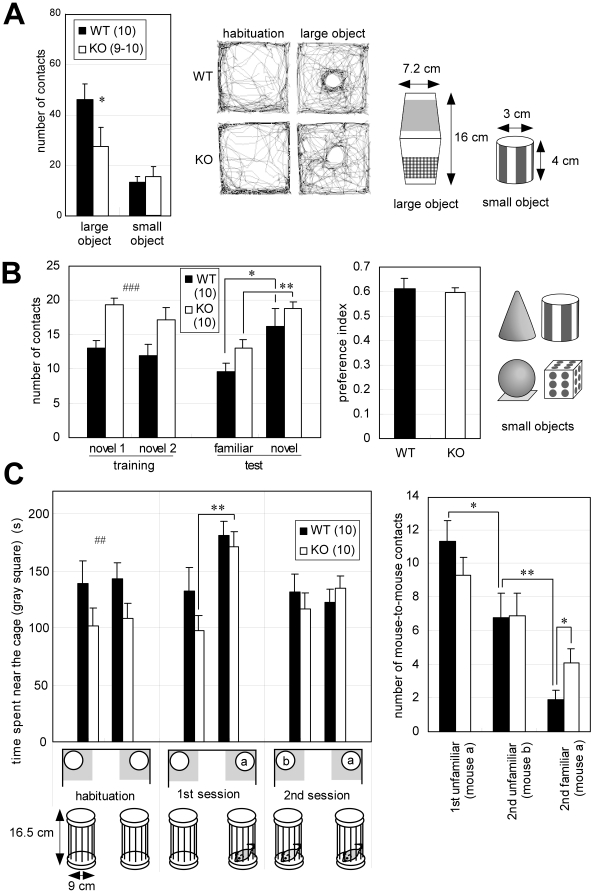
Approach to inanimate and animate objects.(A) Behavioral tests of approach to inanimate objects in the OF. The mice were first placed in the OF box without the object (habituation), then placed again in the OF with the large or small object (right). Approach was measured by the numbers of direct contacts with the large or small object (left). The traces are representative ones of WT and KO mice during the habituation and the test session with the large object (middle; results are given for a pair that showed comparable trace patterns in habituation). Values are presented as means ±SEM. * P<0.05. (B) Novel object recognition test using four kinds of small object (right). novel1 and novel2 indicate that the same kinds of objects were placed in the left and right corners, respectively, of the cages in the training session. familiar and novel indicate respectively that the object was unchanged (novel1) and that a new, differently shaped object was added in place of novel2 in the test session. A novel object preference index was calculated as follows: contacts with novel / total contacts with novel and familiar. Values are presented as means ±SEM. * P<0.05; ** P<0.01. ###
P<0.001 (total contacts, comparison between WT and KO). (C) Social discrimination test. Approach to the cages was measured by the time spent in the rectangular region (indicated as gray squares below graph, 17.7 cm×17.7 cm) that included the cage (left). Mouse-to-mouse contacts (right). Values are presented as means ±SEM. * P<0.05; ** P<0.01. ##
P<0.01 (total stayed time between WT and KO).